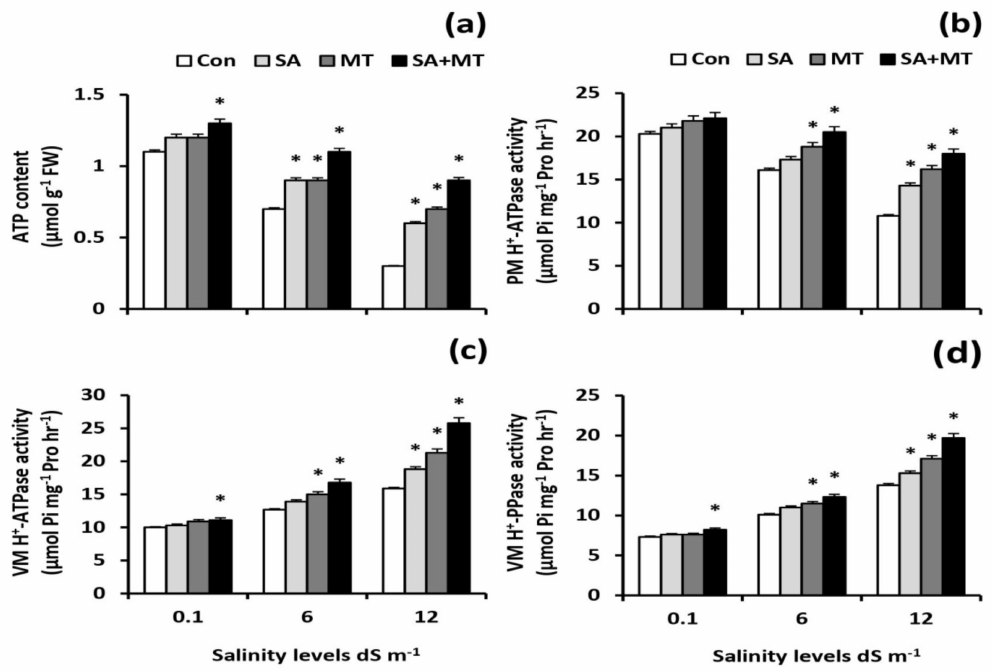
Figure 4. Influence of salicylic acid (SA, 75 mg L − 1 ), melatonin (MT, 70 µ M), and SA (75 mg L − 1 ) + MT (70 µ M) foliar application treatments on the ( a ) ATP content, ( b ) plasma membrane (PM) H + -ATPase activity, ( c ) vacuole membrane (VM) H + -ATPase activity, and ( d ) vacuole membrane (VM) H + -PPase activity in roots of wheat plants grown under 0.1, 6, and 12dS m − 1 salinity levels. Data are means of four replicates (n = 4) and bars show standard errors ( ± SE). Asterisk represent significant differences between treatments at the p < 0.05 level according to LSD